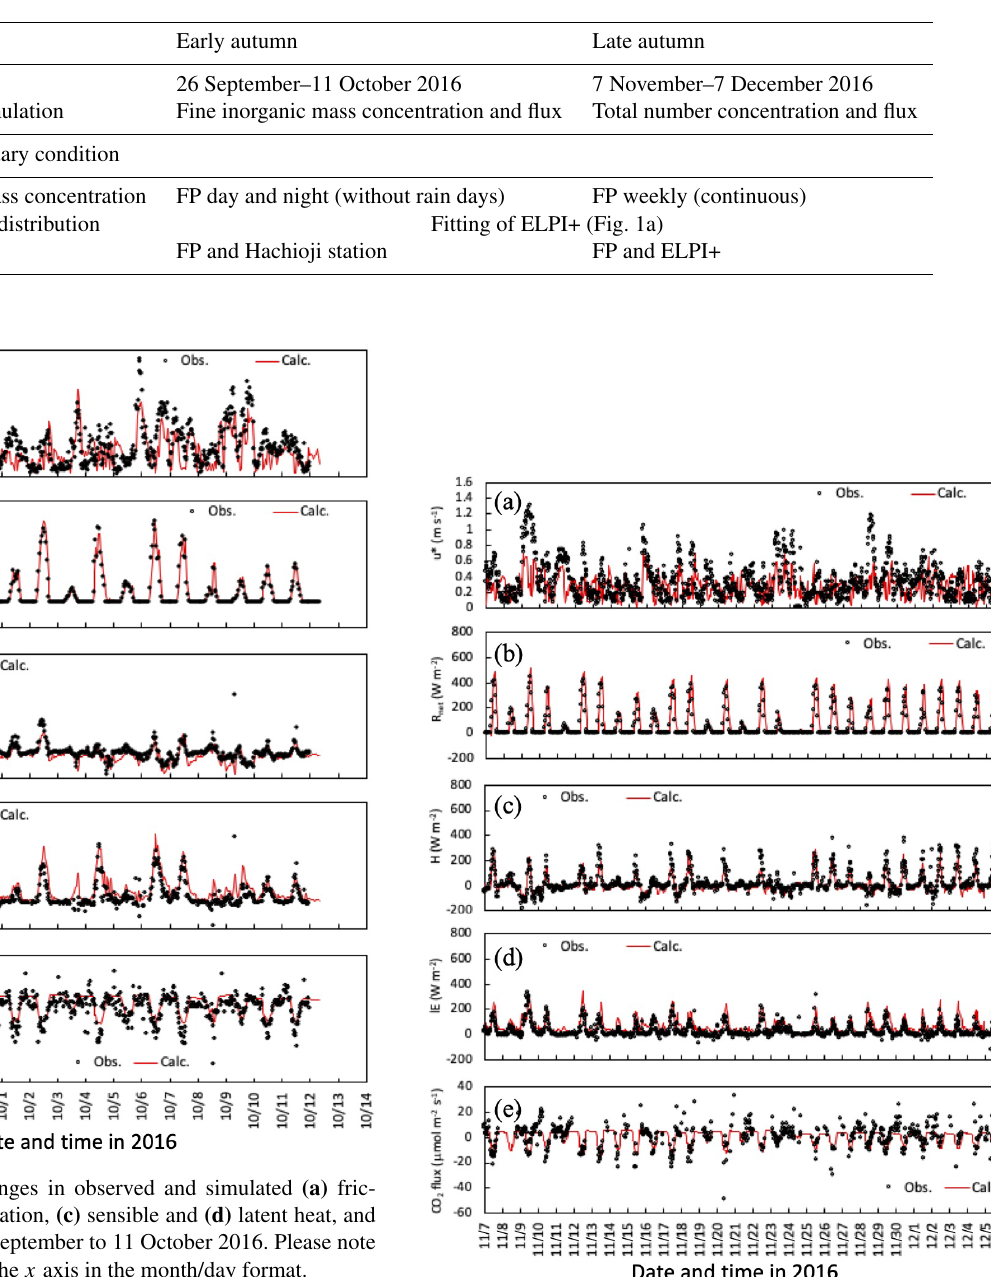
Table 1. Summary of input data, initial conditions, and boundary conditions for the SOLVEG simulation setup. FP: filter-pack measurements; ELPI+: ELPI+ measurements; f io : volume fraction of inorganic compounds. It should be noted that the gaps between FP in rain days of the early-autumn period were linearly interpolated for simulations.